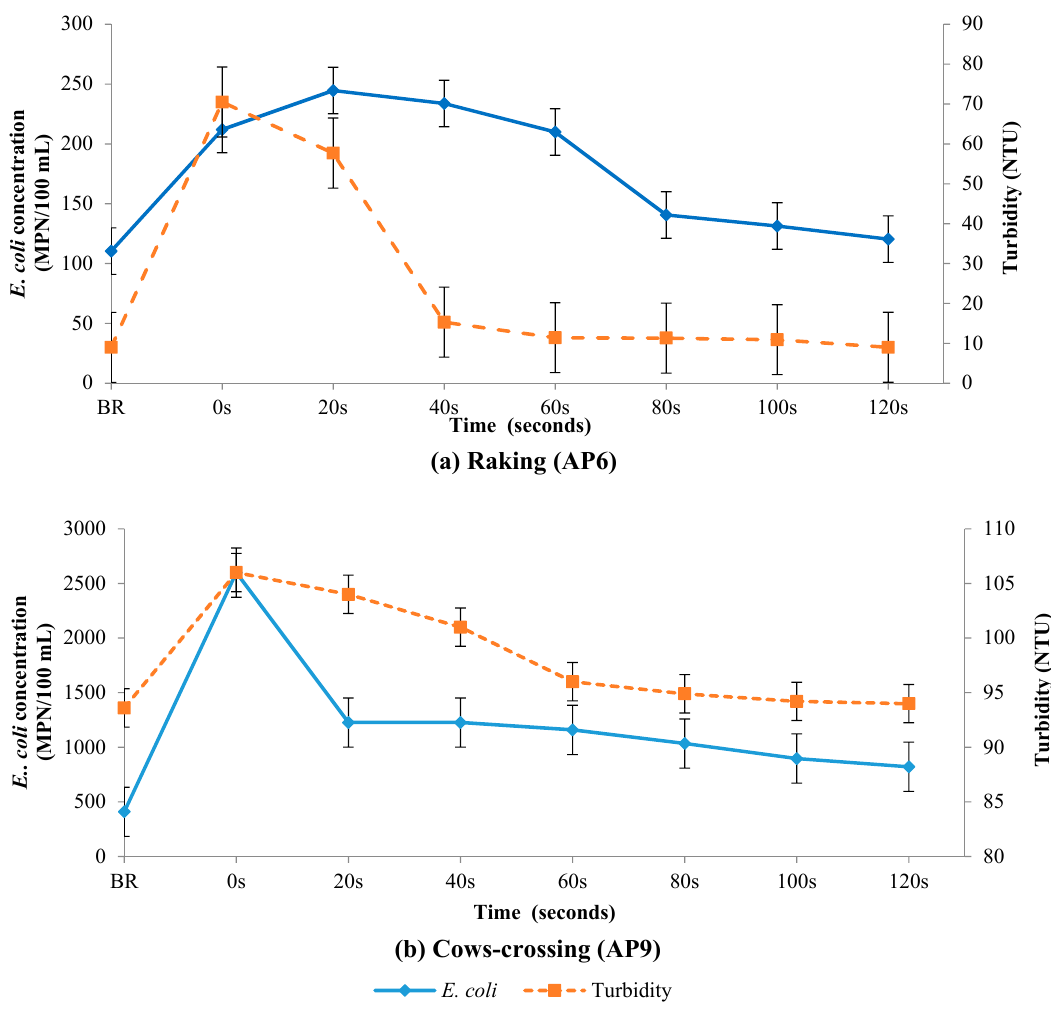
Figure 5. E. coli concentration (solid lines) and turbidity (dashed lines) of the water column before resuspension (BR), followed by ( a ) after raking and ( b ) after cow-crossing.